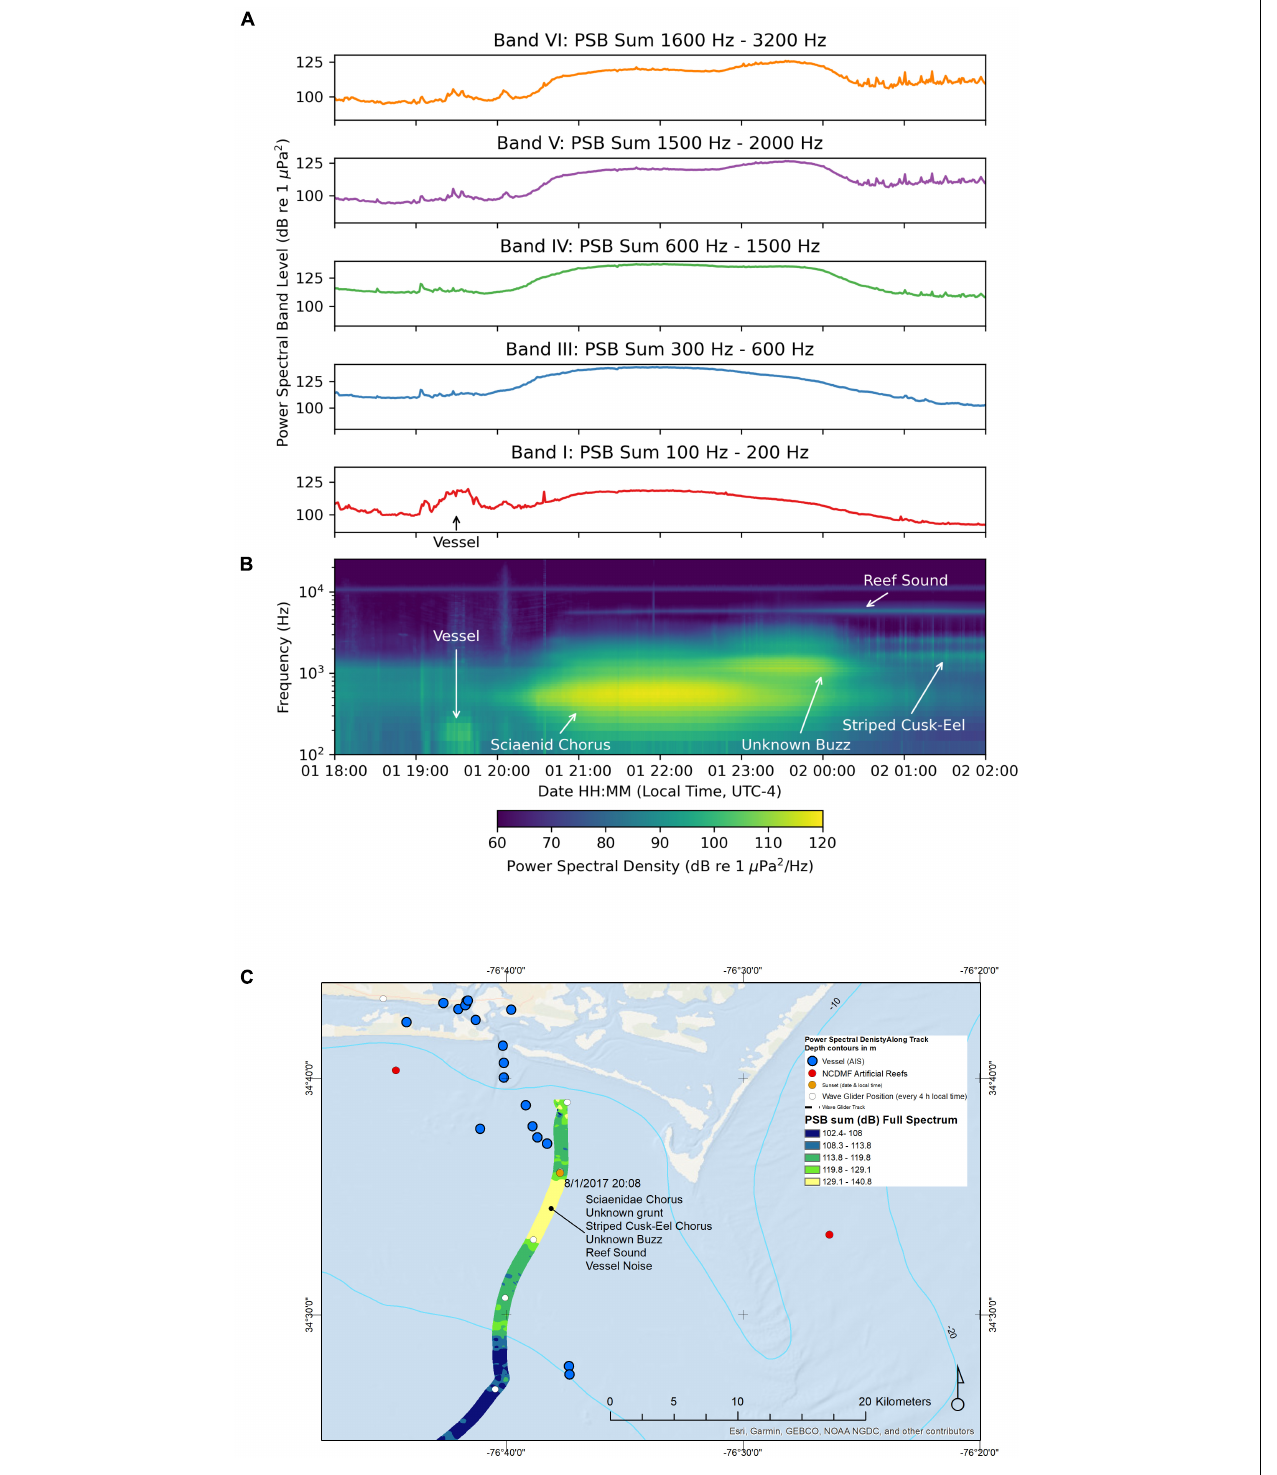
FIGURE 4 | Sound recorded by the wave glider Blackbeard between August-01 18:00 and August-02 02:00. (A) Power spectral band sums for 60 s windows of the recording. (B) Composite spectrogram produced from 60 s average power spectral densities. (C) Map of the path of the wave glider during the recording. The color of the path indicates the full spectrum PSB sum detected at the